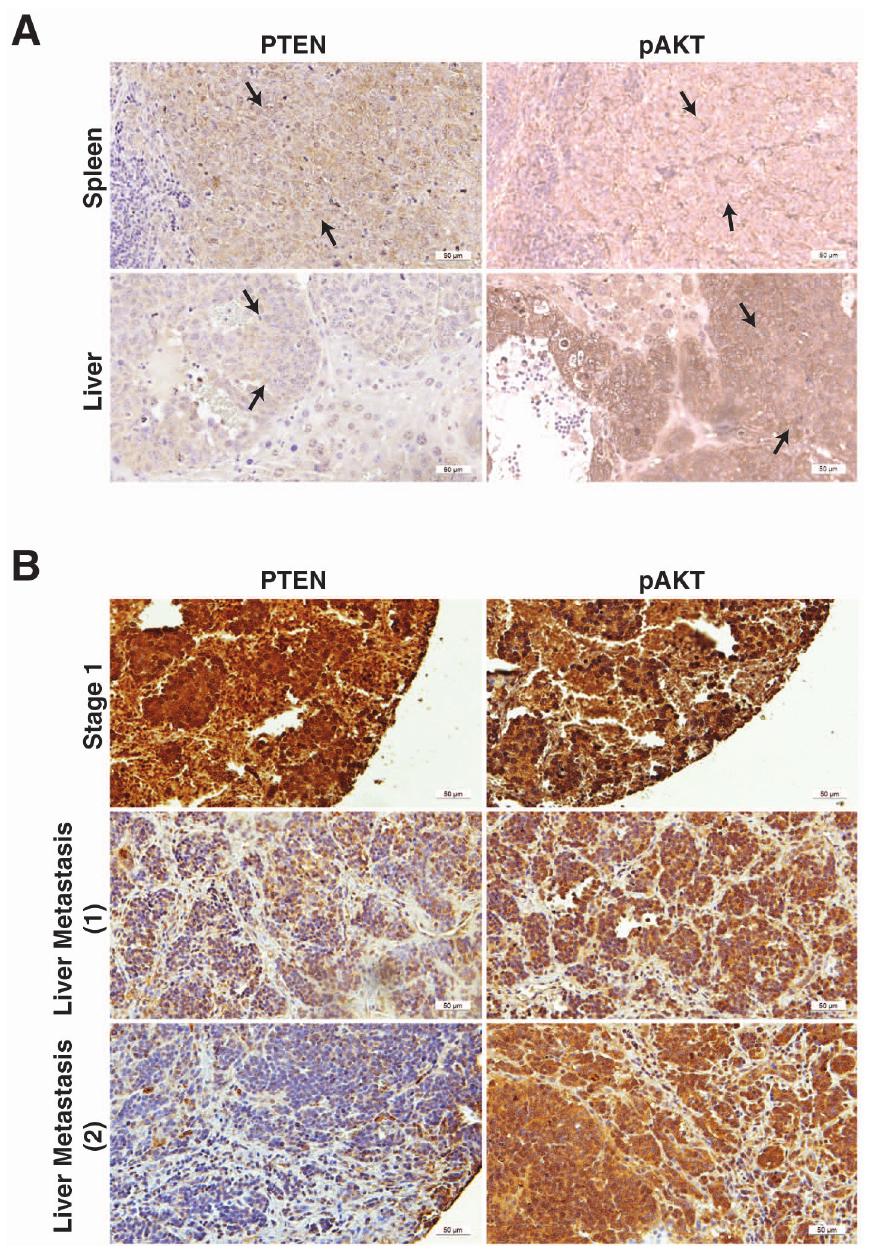
Figure 4. Inverse pattern of PTEN and pAKT expression in metastatic lesions. (A) Immunohistochemistry demonstrated increased pAKT expression in liver lesions ( brown staining; bottom right ) from our in vivo spleen-liver metastasis model in comparison to primary splenic tumors, whereas, PTEN expression was slightly decreased in metastatic liver foci when compared to primary splenic tumors ( brown staining; top left ) (black arrows indicate tumors). (B) PTEN expression was lower in liver metastatic sections from human neuroblastoma samples in comparison to sections from primary localized tumors. pAKT expression was comparatively higher in patients with liver metastasis.